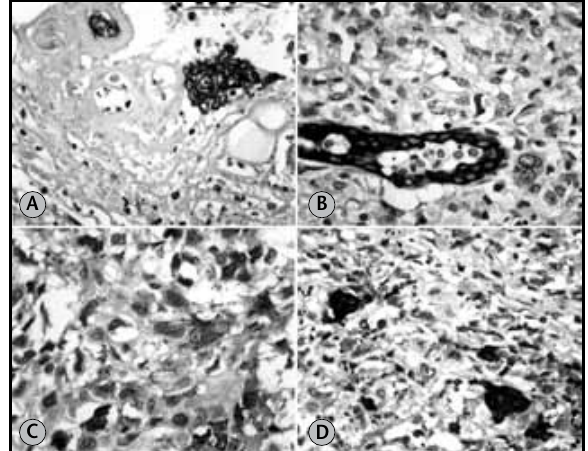
Figure 5 – Photomicrographs showing immunohistochemical features of the carcinosarcoma. (A) Undifferentiated carcinoma expressing cytokeratin (AE1/AE3, DAKO); (B) preexisting ducts of the parotid land involved by a high-grade neoplasm (AE1/AE3, DAKO); (C) weak and focal expression of EMA in undifferentiated carcinomatous areas; (D) CD68 expression in the giant cell component EMA: epithelial membrane antigen. All photomicrographs taken at 400× magni-